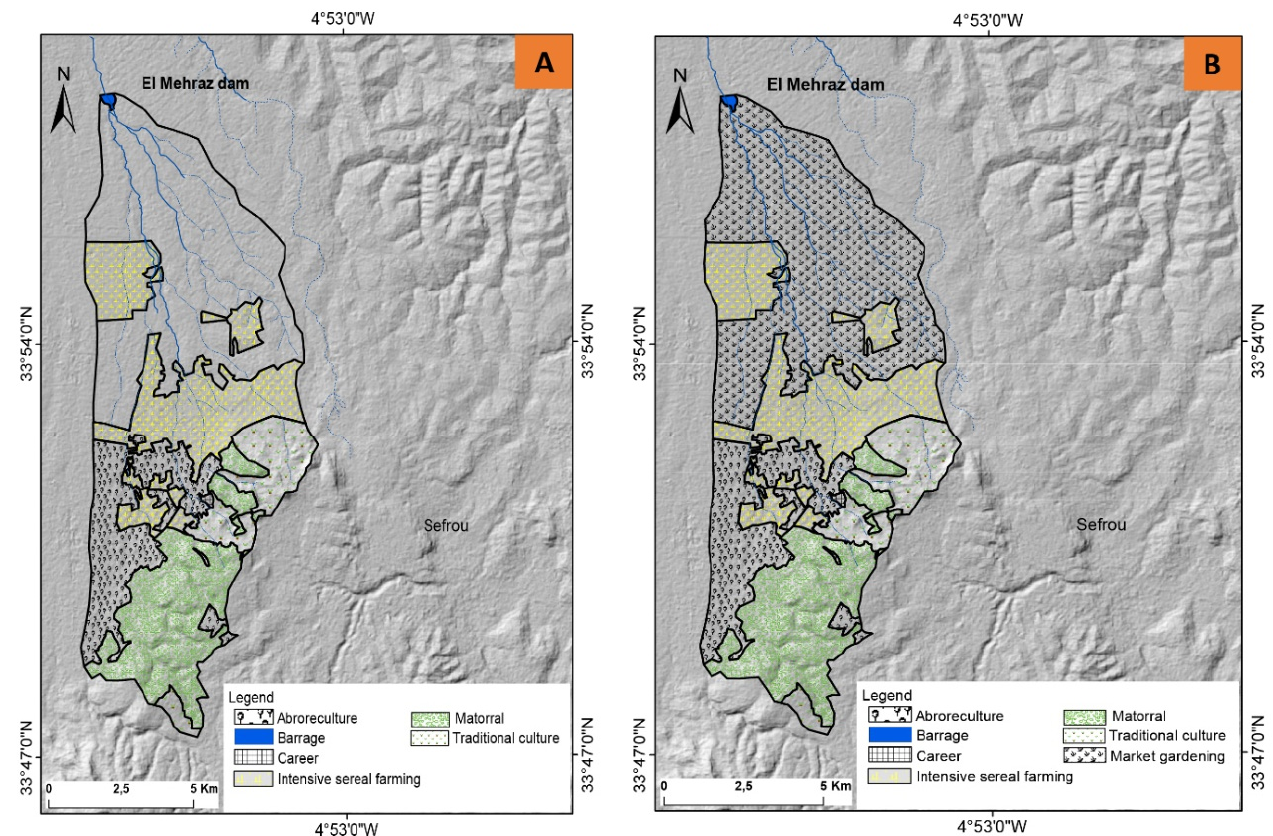
Figure 5. The expansion of farmland and urban landscapes in Fez peri-urban areas over the last 20 years: ( A ) watershed farmlands in 2020; ( B ) watershed farmlands in 2020. Studied habitats were frequented by a substantial number of tourists. The Ain Chkef Forest and El Gaada Dam were visited by a total of 341,828 and 70,179 tourists, respec- tively, principally during the October–January and March–June periods (Figure 6). The El Mehraz Dam (1049 visitors), the Ain Bida Dump (3958 visitors), and the Oued Fez River (18,652 visitors) were visited by a lower number of tourists. During 2017–2018 and 2019–2020, the El Mehraz dam was completely dry (Figure 7). The populations of water birds (79 species), including resident and migrant species, were directly impacted. Moreover, breeding attempts of the white-headed duck (32 nestlings) and the ferruginous duck (four chicks) were not successful due to the absence of water and feeding resources. The main factor influencing the water body of the dam was represented by farmlands (olives and vegetables) that require huge quantities of water for irrigation, particularly during the hot summer, coinciding with the breeding period of the majority of recorded